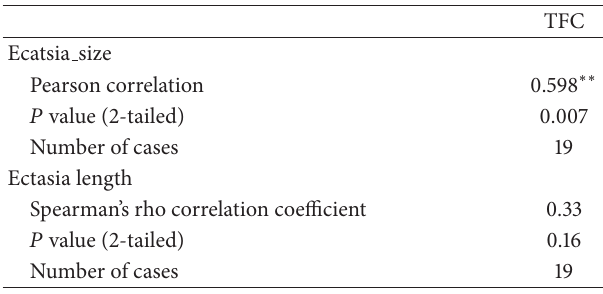
Table 2: Correlation of ectasia size and length with TIMI frame count (TFC) in the right coronary